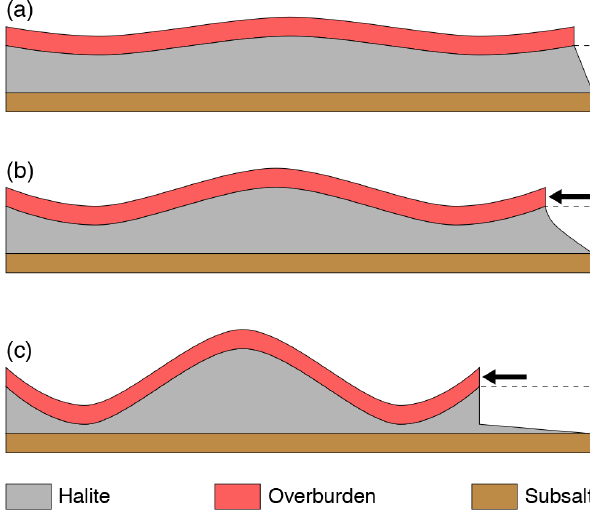
Figure 9. Possible changes in intrasalt shear profile during progres- sive shortening and growth of contractional anticlines: (a) incipient shortening accommodated by Couette flow; (b) as synclines sink and the zone of shear becomes more concentrated, Couette flow be- comes modified; (c) as the salt beneath the synclines thins, intrasalt basal shear becomes increasingly dominant. Complex intrasalt de- formation in the anticlinal cores is not